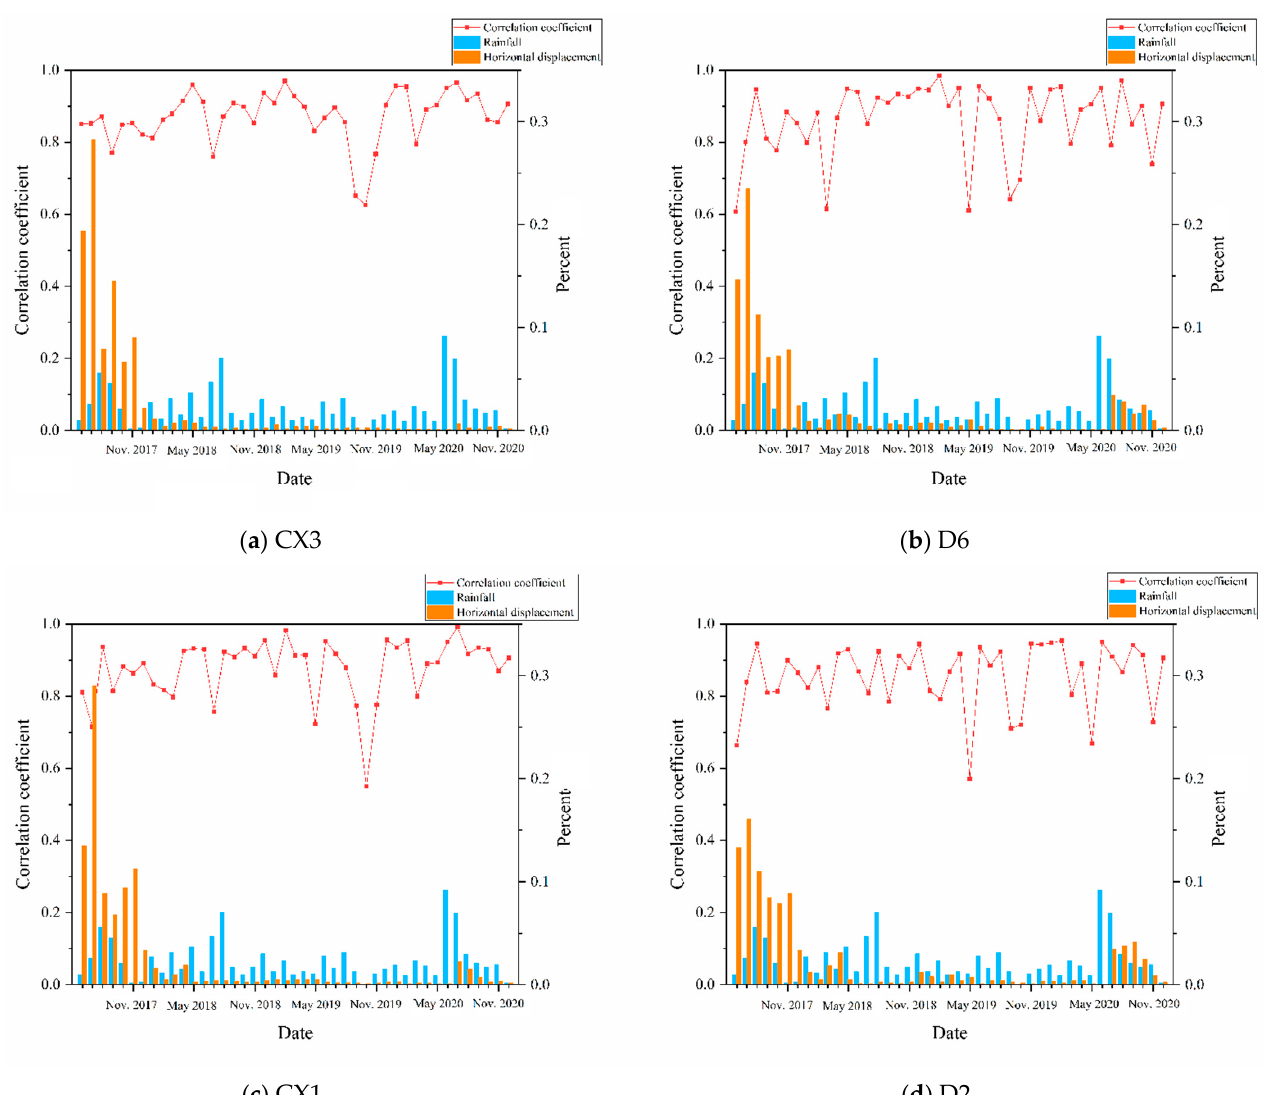
Figure 18. Relationship between rainfall and landslide displacement. The orange histogram represents the ratio of the monthly displacement to the total monitored displacement from 11 June 2016 to 11 December 2022, and the blue histogram represents the ratio of the monthly rainfall to the total accumulated rainfall from 11 June 2016 to 11 December 2022.